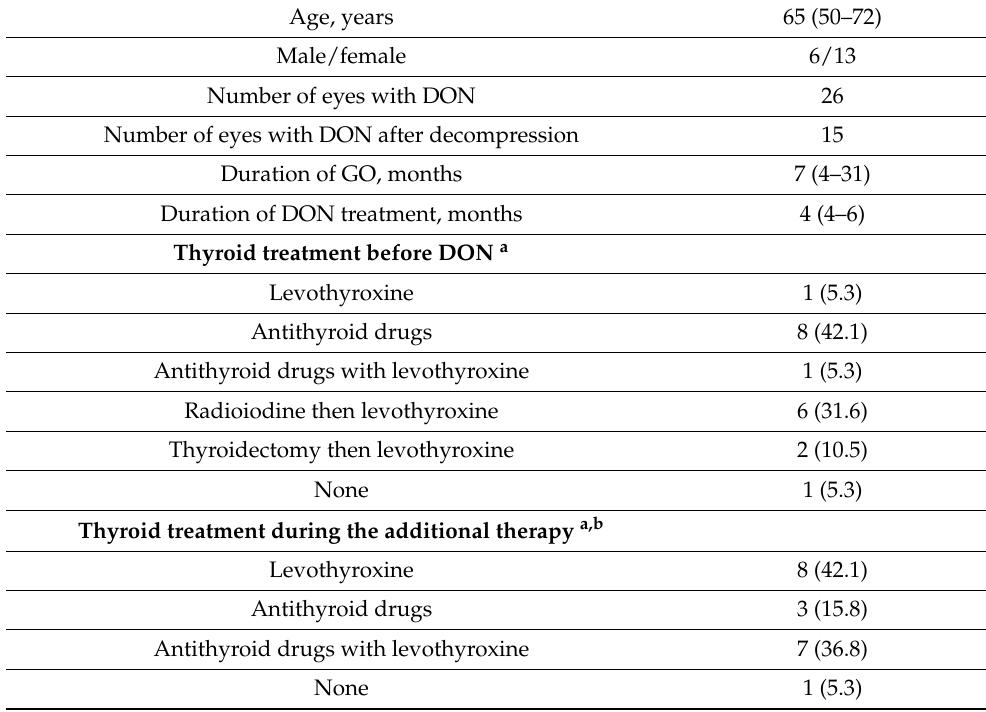
Table 1. Baseline demographic characteristics.